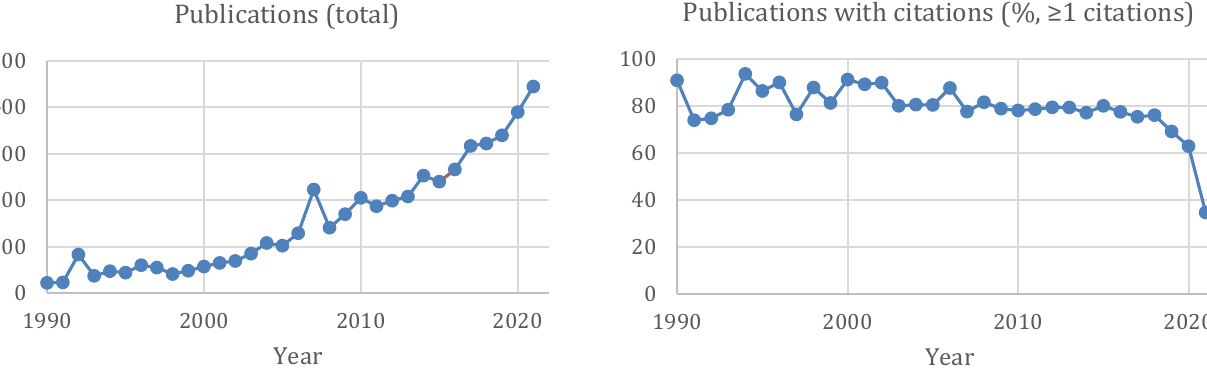
Figure 1. The total number of publications and citations with the phrase “Electrical Impedance Tomography” in the title or abstract raised exponentially each year (left), while the number of publications with the same criteria but having at least one citation, stayed the same and dropped slightly over the past four years (right)